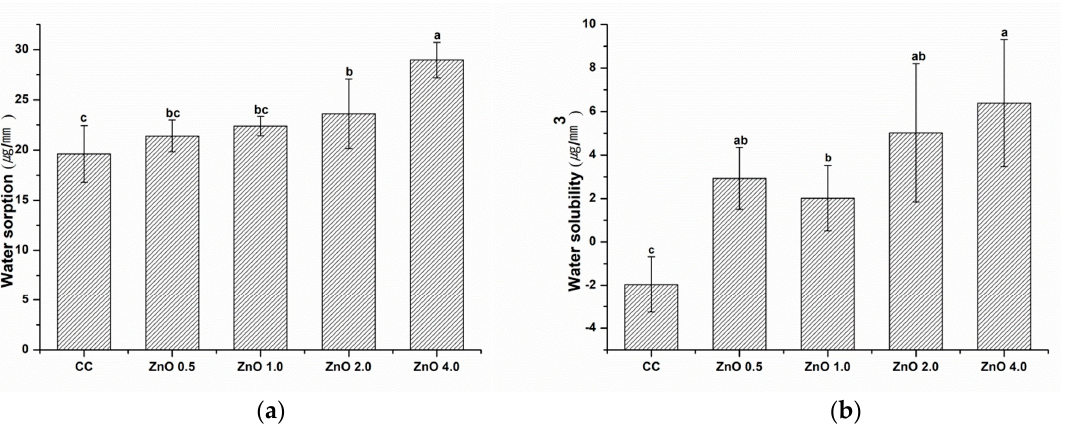
Figure 8. ( a ) Water sorption and ( b ) water solubility. Different letters indicate significant differences ( p < 0.05). The error bars show the standard deviation of the mean values.